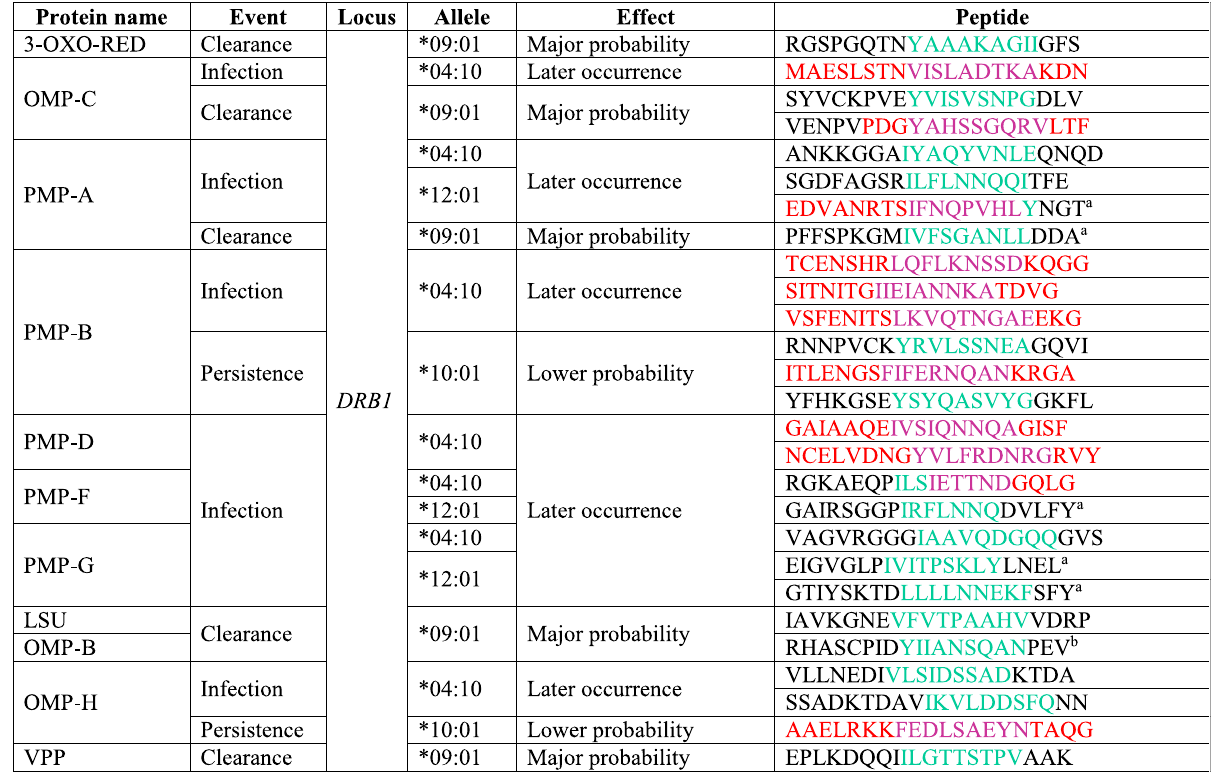
Table 4. Protein regions having the potential to be T- or B-cell epitopes. T-(green) or B-cell (red) epitope prediction is shown; regions having dual prediction are shown in purple. a Peptides which could be related to GP of clearance when they are presented by the same allele. b Peptides related to LP of persistence when presented by DRB1 *10:01